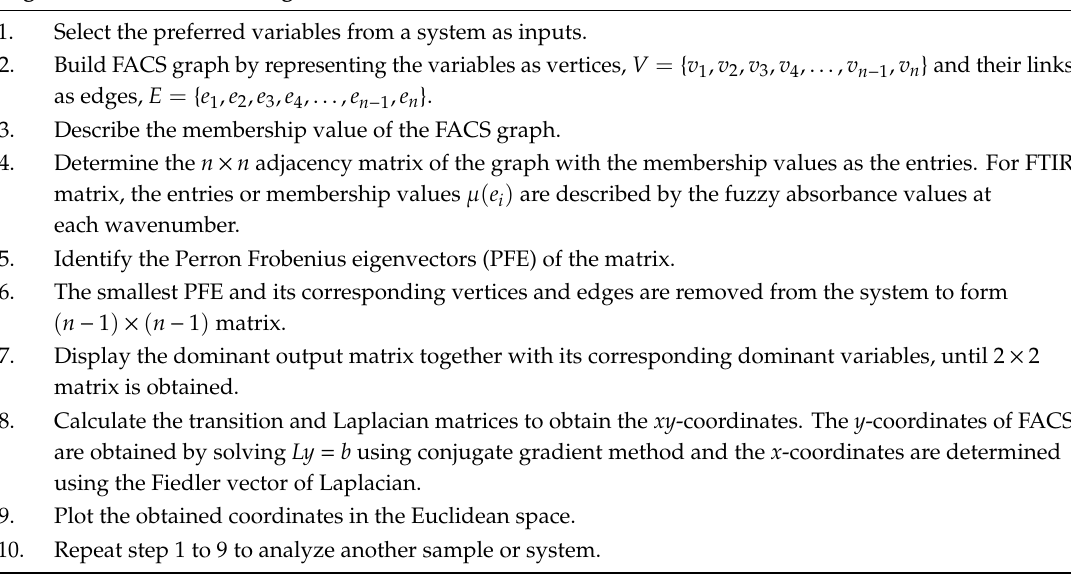
Algorithm 1: The c-FACS